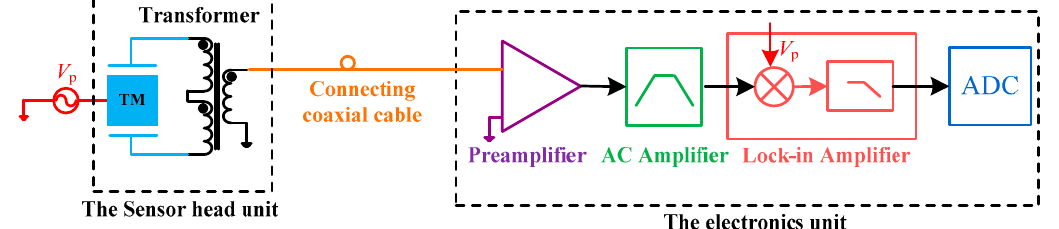
Figure 1. Schematic diagram of capacitive sensing circuit with a coaxial cable.